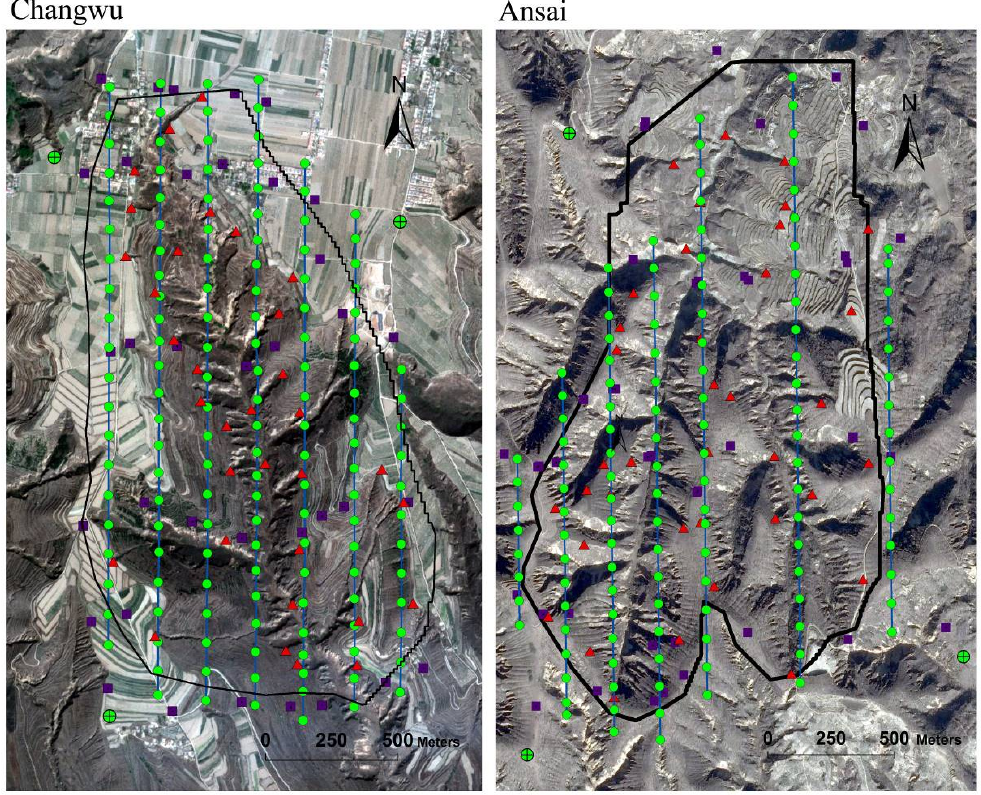
Figure 4. Overview of the survey design including the flight lines, locations of base control points (BCPs), photos control points (PCPs) and independent check points (ICPs). The background images are acquired from Google TM Earth. Transformations from China Geodetic Coordinate System 2000 to Mercator were made for all ground control points (GCPs) and fight lines using the projection tool in ArcMap.